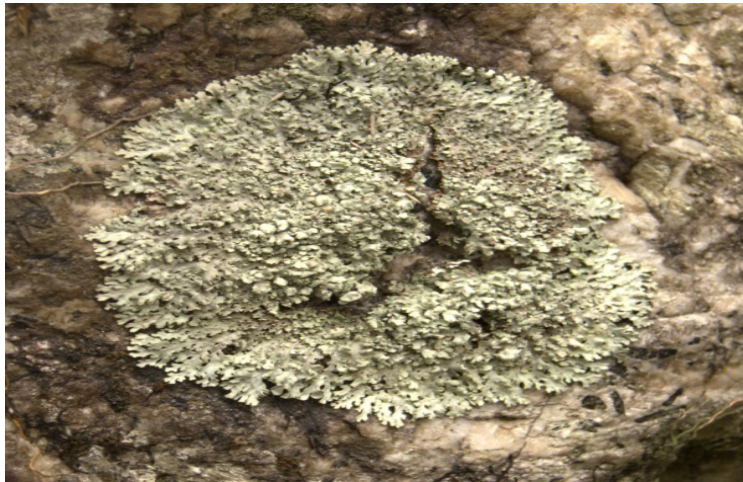
Figure1. Parmeliaflexilis inhabiting exposed rock in Ghandruk, Kaski, Nepal. Figure 1. Parmelia flexilis inhabiting exposed rock in Ghandruk, Kaski,